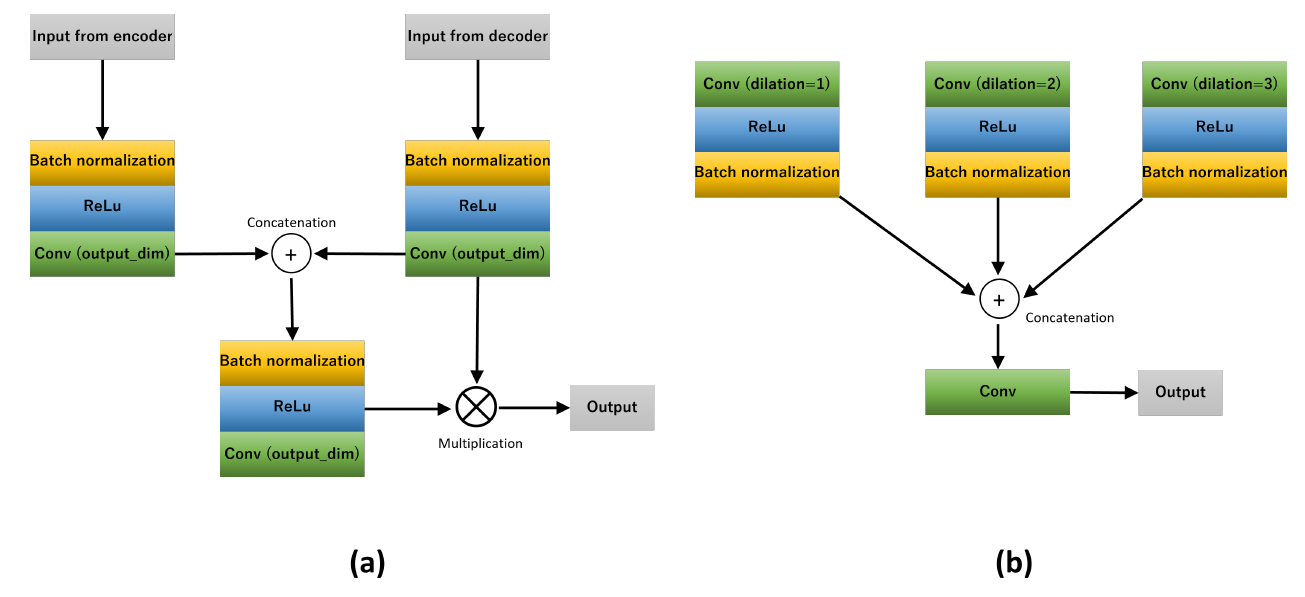
Figure 3. ( a ) the structure of attention mechanism and ( b ) the structure of ASPP